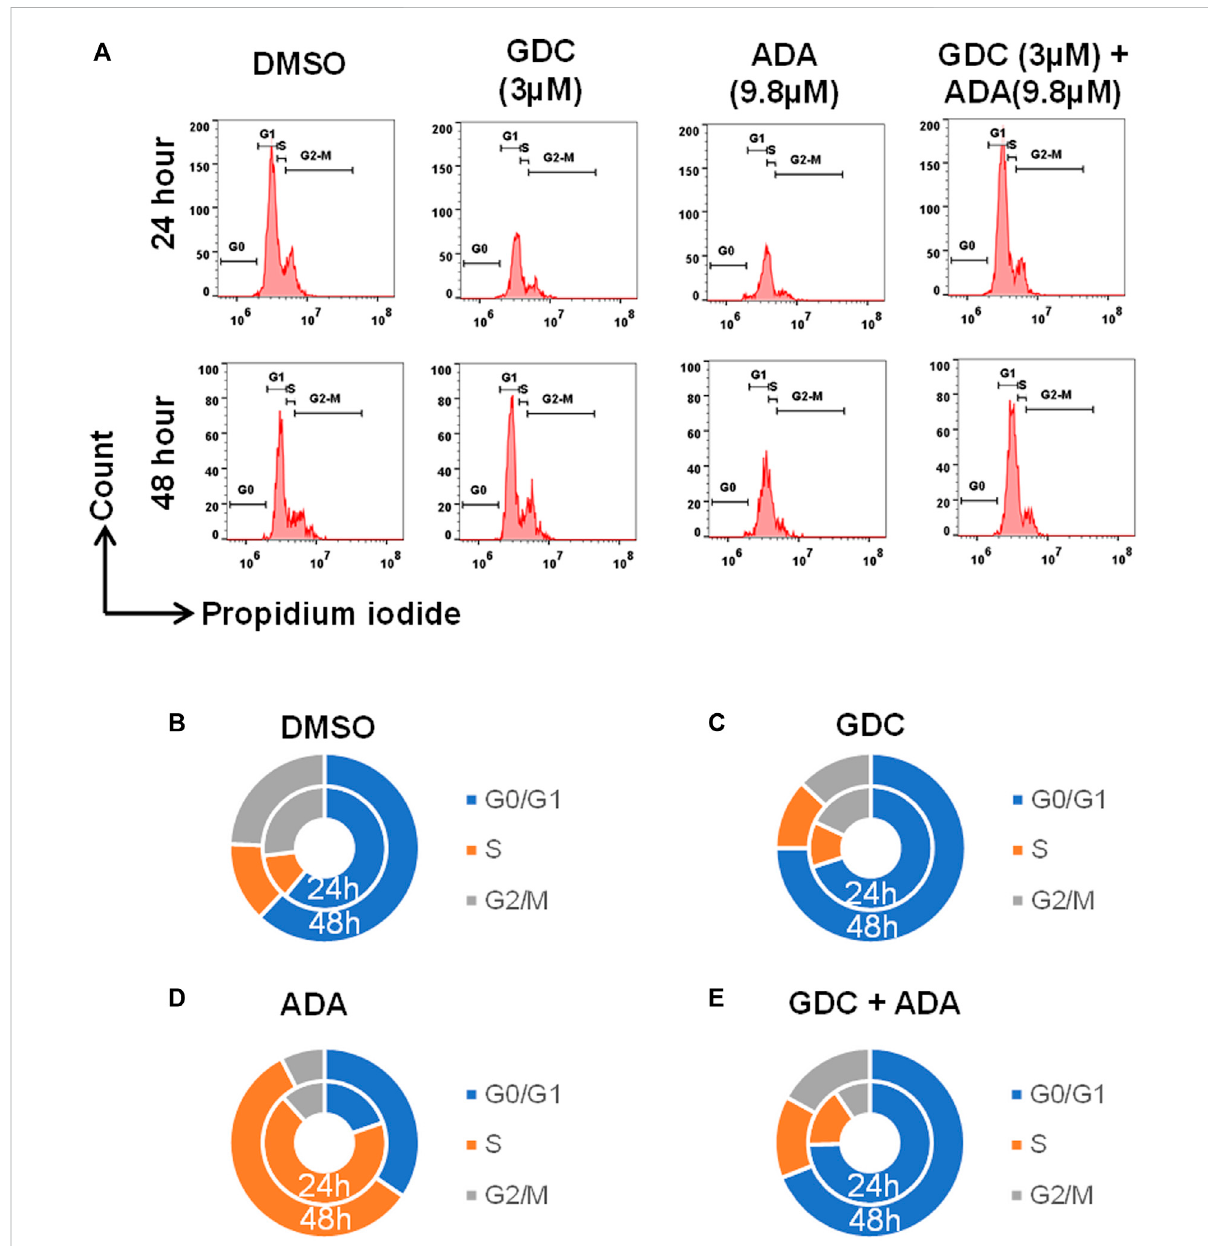
FIGURE 7 GDC-0941 and adapalene promoted cell cycle arrest of MDA-MB-231 cells (A – E) ADA upon treatment showed S-phase arrest of MDA-MB- 231 cells, while GDC showed the arrest of MDA-MB-231 cells in the G2/M phase of the cell cycle. Upon combination treatment with GDC and ADA, the arrest of cells enhanced in the